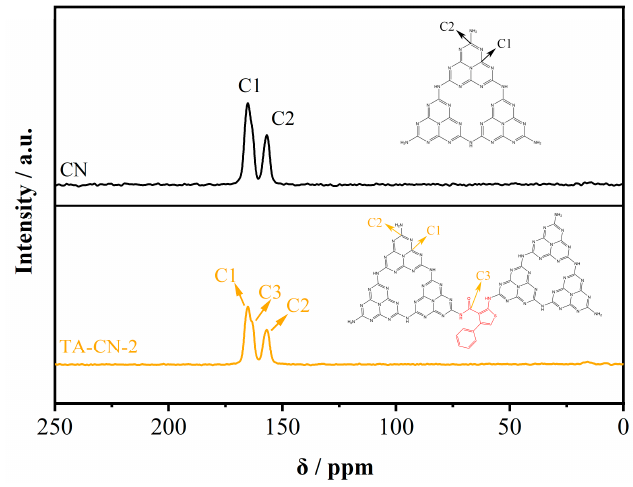
Figure 5. 13 C ssNMR spectra of CN and TA-CN-2.